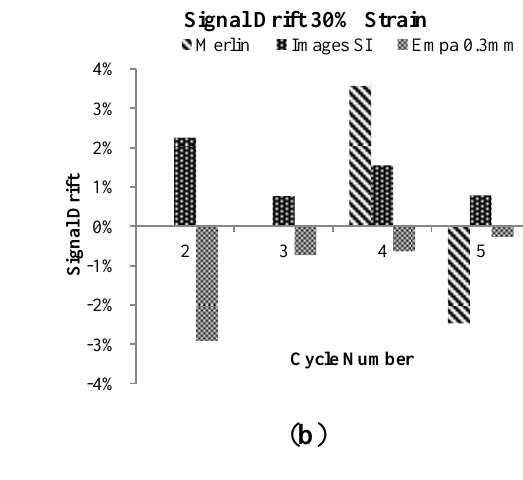
Figure 7. ( a ) Signal relaxation and drift ( b ) results at the 30% strain